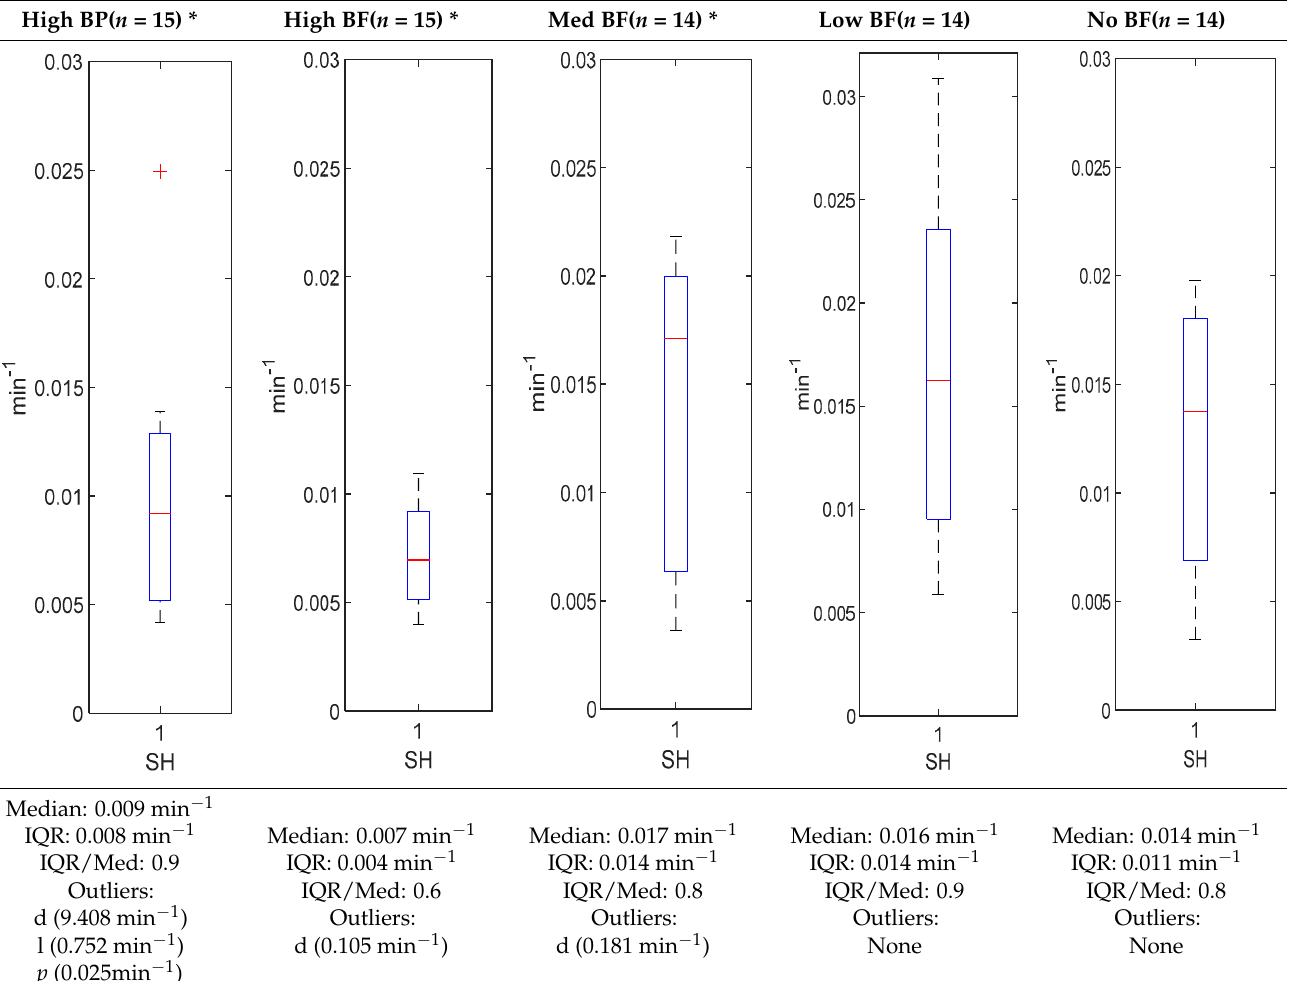
Table A1. K SH estimation results.